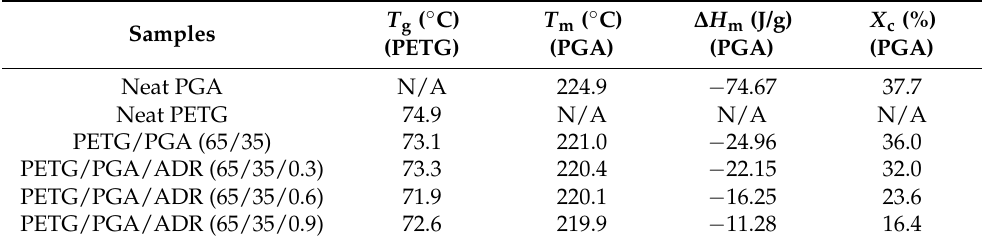
Table 5. DSC parameters of neat PGA, PETG, and PETG/PGA/ADR (65/35/x) samples.